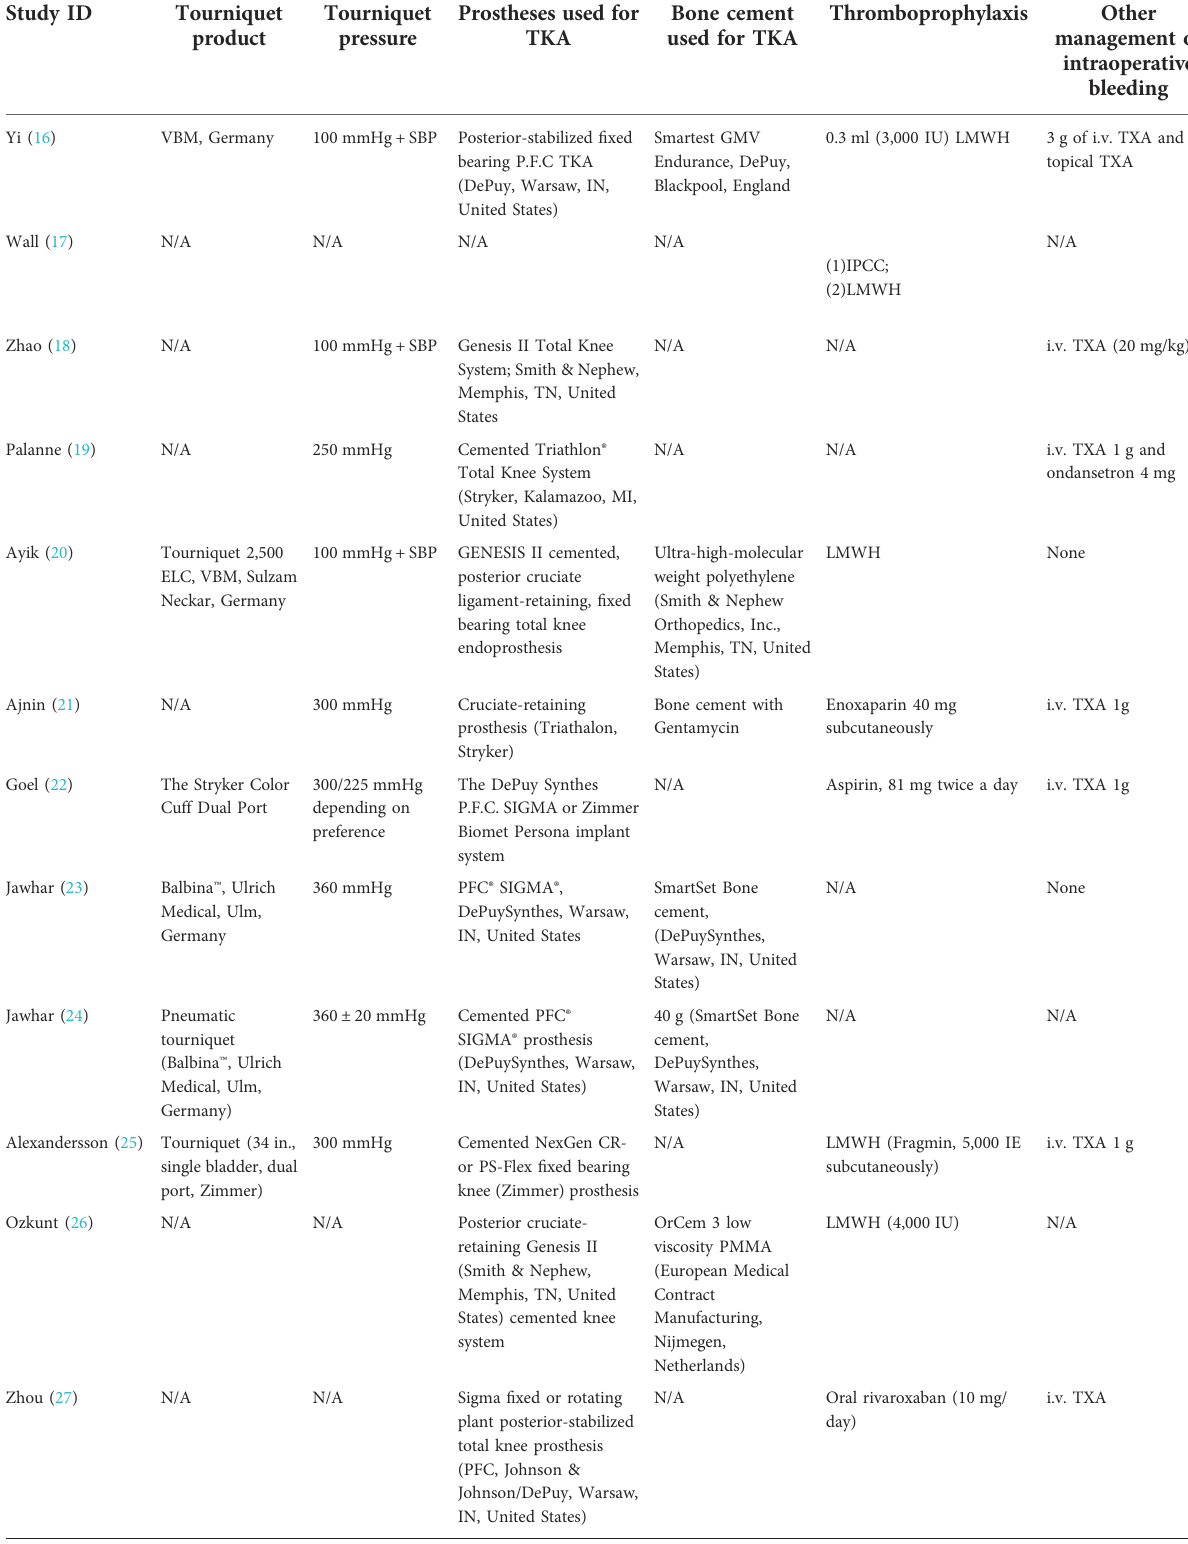
TABLE 2 Detailed information about the operation